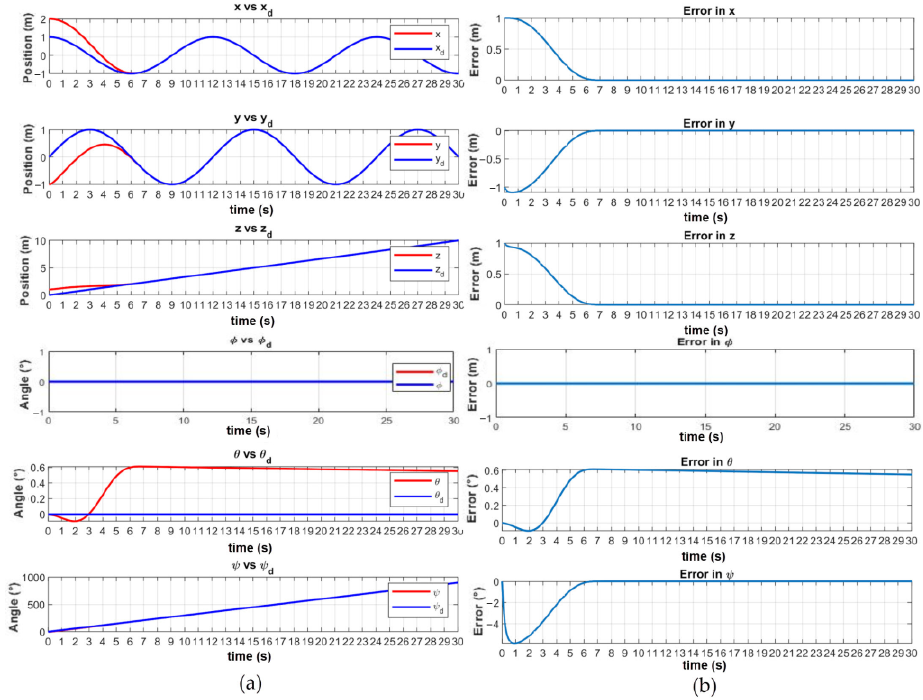
Figure 9. Results with 𝑡 𝑏 = 7 s . ( a ) Trajectory tracking. ( b ) Position tracking errors.